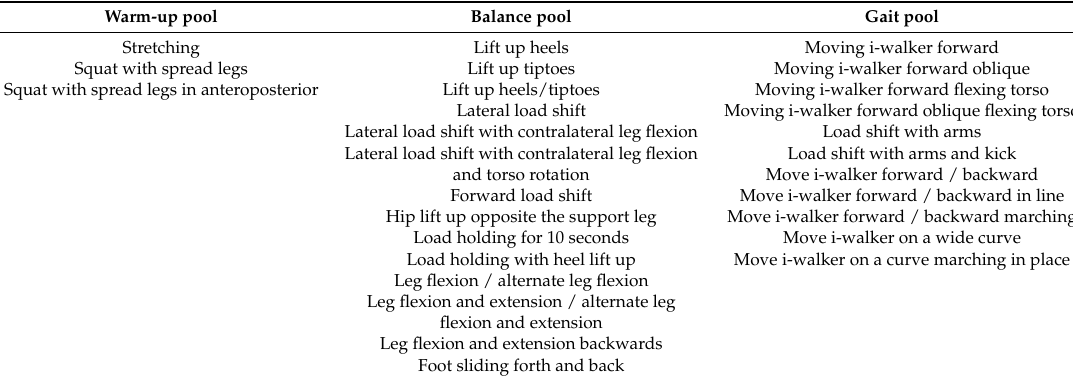
Table A2. Balance and Gait